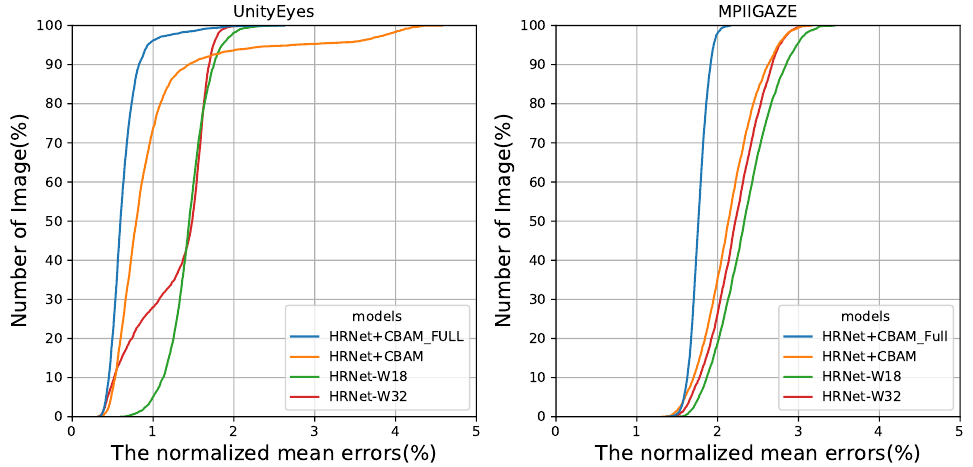
Figure 10. Comparisons of the cumulative error distribution curves of the test datasets. We compared our method with baseline approaches (HRNet). HRNet+CBAM and HRNet+CBAM_FULL denote adding a residual CBAM layer and applying CBAM to all stages of the residual blocks,